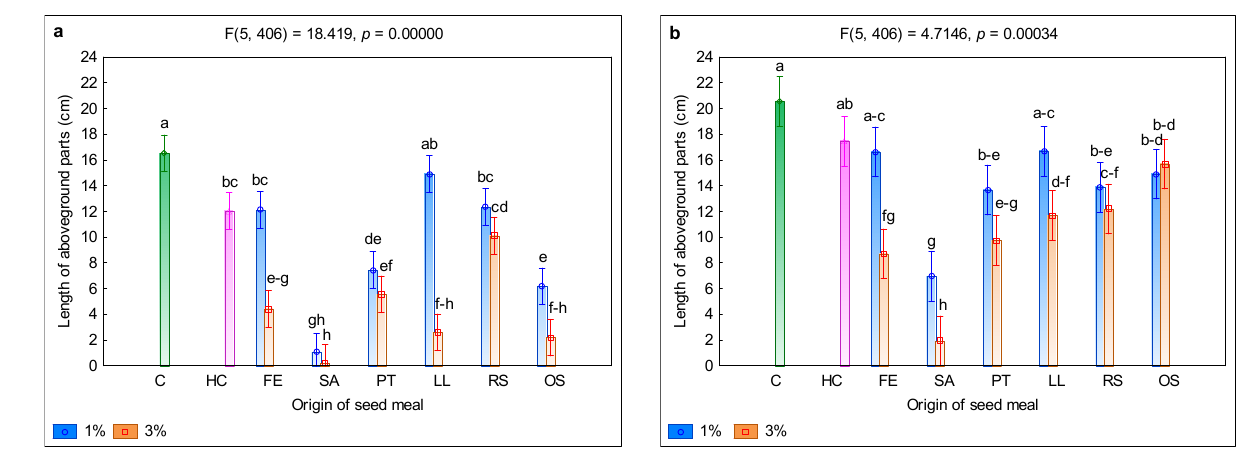
Figure 1. The mean length of aboveground parts of herbicide-susceptible ( a ) and -resistant ( b ) biotypes of wild oat depending on the origin of seed meals and their concentration. Means with various letters are significantly different, according to Tukey test ( p ≤ 0.05). Vertical bars mean 0.95 confidence intervals. The symbols mean C—control, HC—herbicide control, and seed meals from FE— Fagophyrum esculentum , SA— Sinapis alba , PT— Phacelia tanacetifolia , LL— Lupinus luteus , RS— Raphanus sativus , OS— Ornithopus sativus . The column colors mean green—control, pink—herbicide control, blue—1% concentration of seed meals, orange—3% concentration of seed meals.